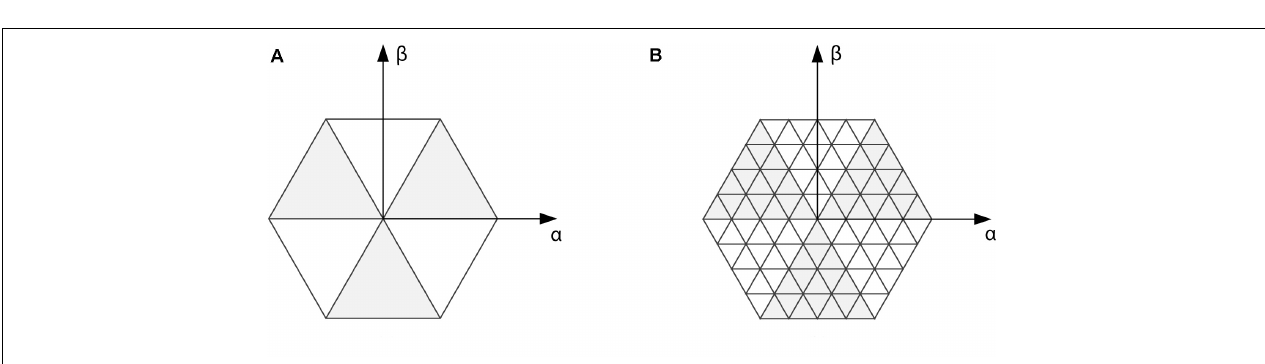
FIGURE 12 | Pulse-width modulation: (A) vertical phase disposition PWM carriers for five-level inverters; (B) vertical phase opposition PWM carriers for five-level inverters; (C) vertical alternative phase disposition PWM carriers for five-level inverters; (D) horizontal disposition PWM carriers for five-level inverters using based on four carriers and one reference voltage; (E) horizontal disposition PWM carriers for five-level inverters based on two carriers and two reference voltages; (F) horizontal-disposition PWM carriers for five-level inverters using a single carrier and a modified reference voltage.